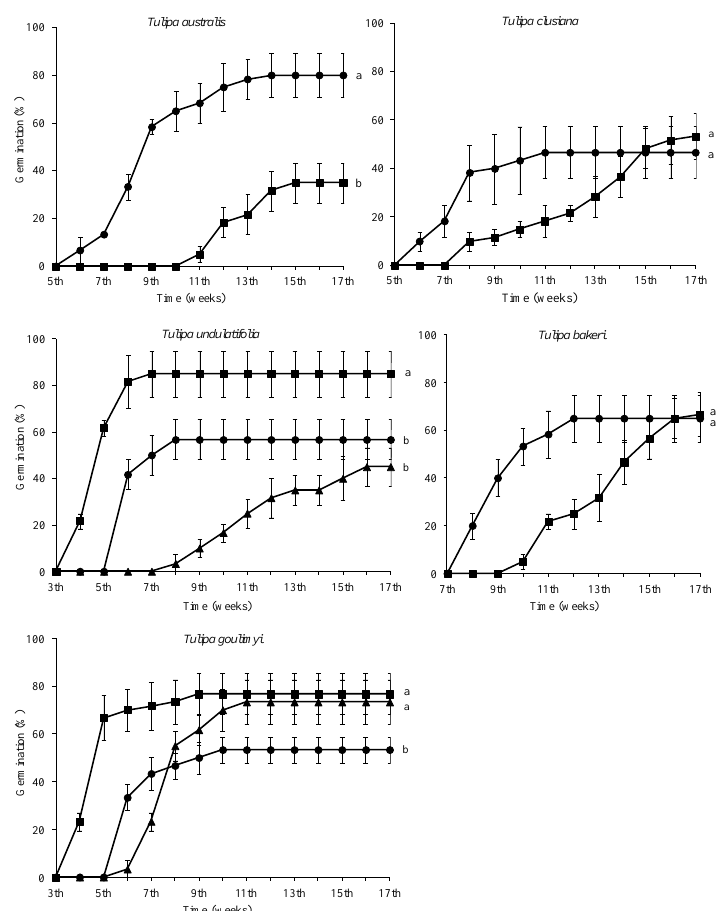
Figure 7. Cumulative seed germination percentage diagrams of Greek Tulipa australis , T. bakeri , T. clusiana , T. goulimyi , and T. undulatifolia incubated at 5 (●), 10 ( ■ ), and 15 °C ( ▲ ). In each species, means are statistically different at p < 0.05 according to Duncan’s test; values followed by the same letter are not statistically different.